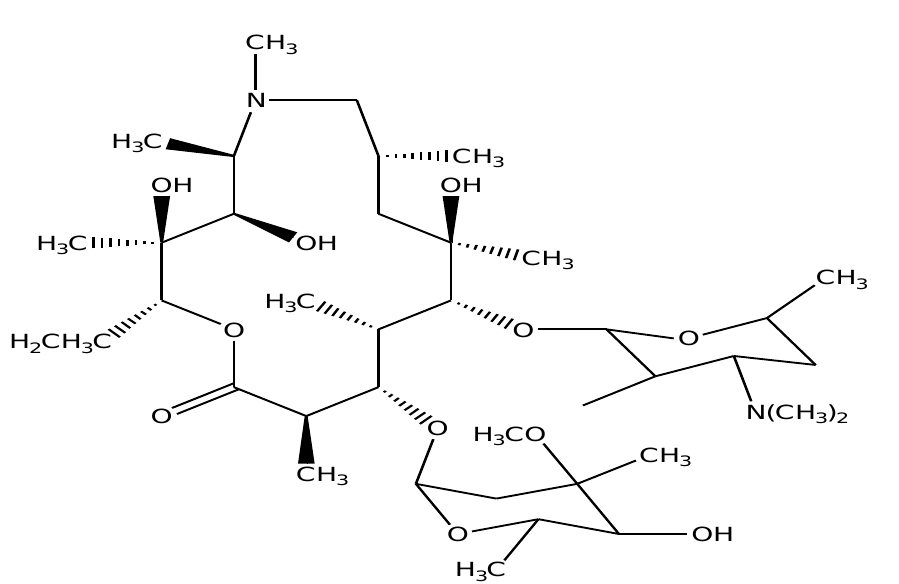
Figure 1. Chemical structure of Azithromycin.